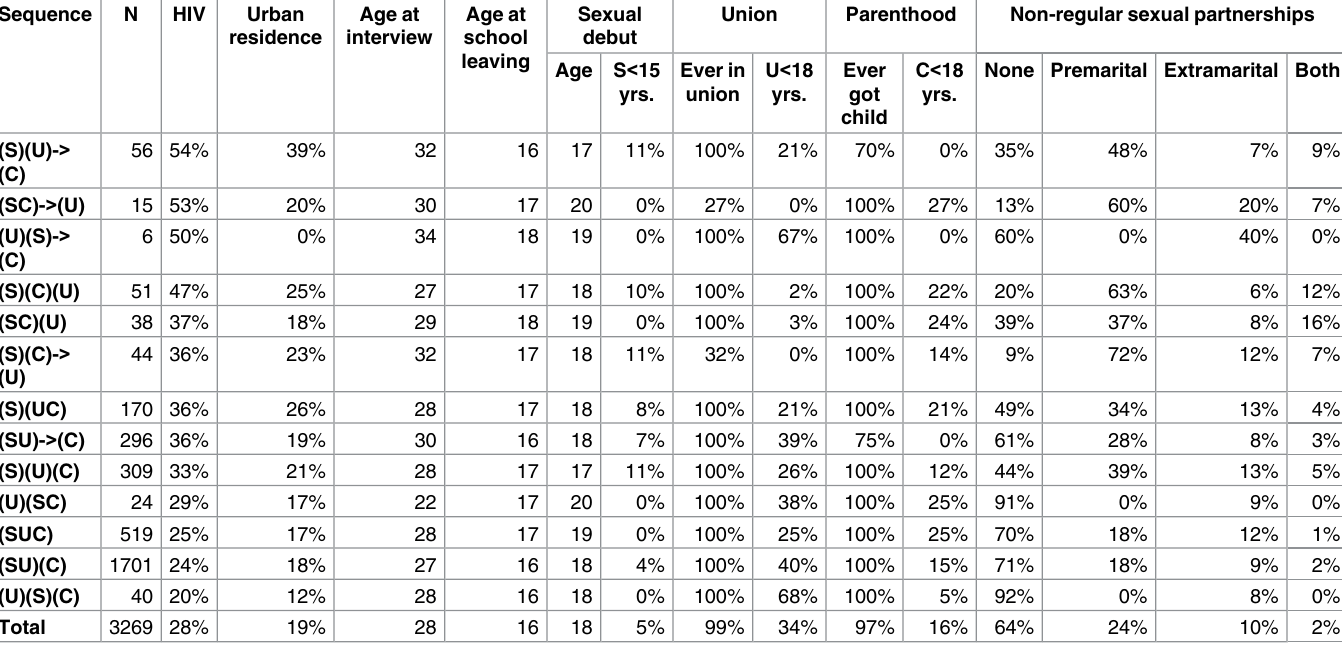
Table 1. Characteristics of women included in the sample. Descriptive statistics on socio-demographic and sexual behaviourcharacteristics for women, stratified by sequence, and overall, Manicaland (Zimbabwe), 2000–2011. Sequences are sorted in descendingorder by HIV prevalence. Sequence N HIV